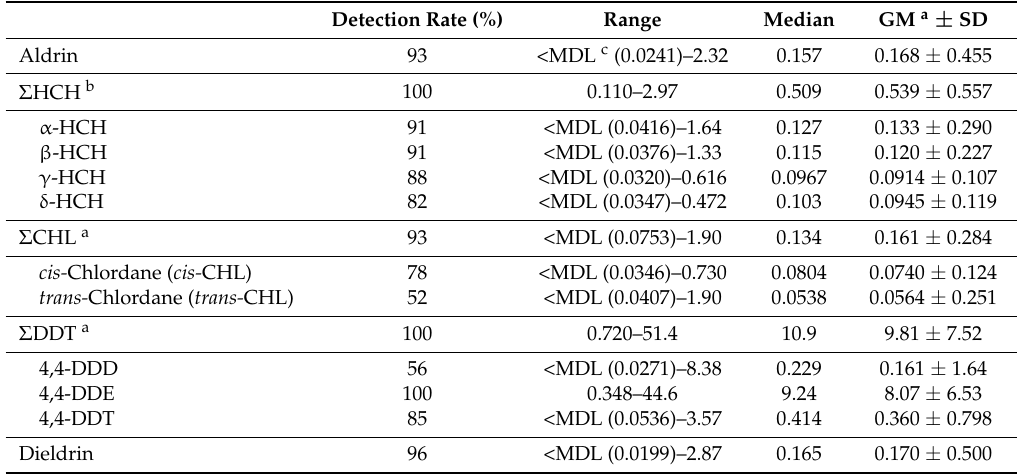
Table 3. Concentrations (ng · g − 1 · lipid − 1 ) of OCP residues in breast milk ( n = 68). Detection Rate